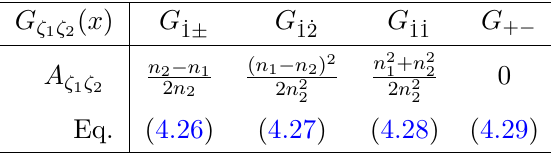
Table 3 . Values of A ζ in the different four-point functions with neutral 1 ζ 2